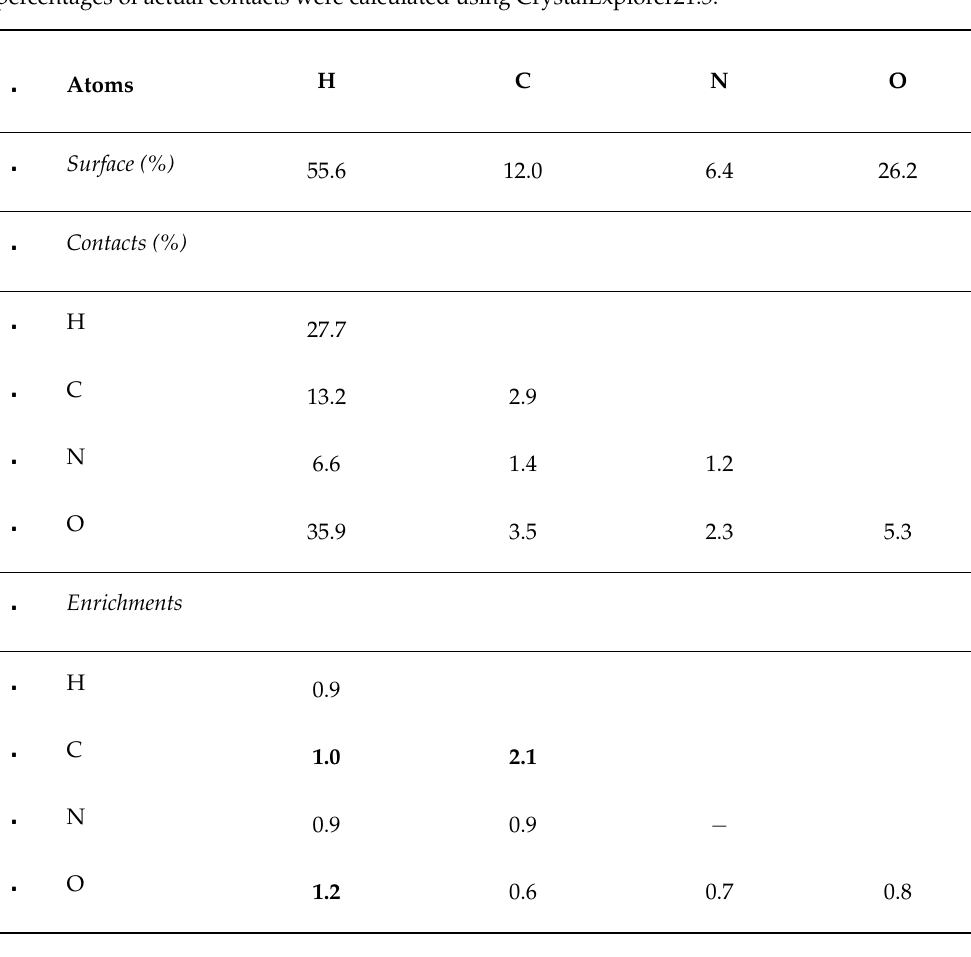
Table 3. Analysis of the intermolecular contacts on the HS of 2 , according to Jelsch et al. [57]. The first part of the table gives the surface contribution S X of each chemical type X to the Hirshfeld surface. The second part shows the proportions of the actual contacts (C XY ), and the third part indicates the enrichment ratios (E XY ) of the various contact types. Reciprocal contacts X ··· Y and Y ··· X are merged. E XY were not computed when the random contacts (R XY ) were lower than 0.9%. E XY ratios larger than unity indicate enriched contacts (in bold), while those lower than unity are impoverished. The percentages of actual contacts were calculated using